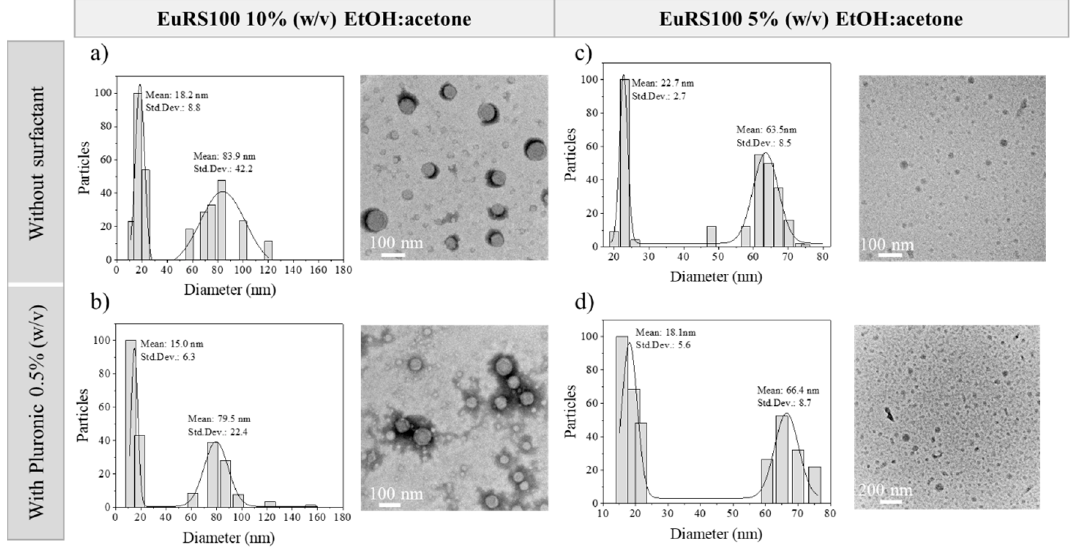
Figure 4. DLS size distribution, representative TEM ( a and b ) or SEM ( c and d ) images of the resulting nanoparticles. ( a ) Eudragit ® RS100 10% (w/v) EtOH:acetone, R = 5, without surfactant, ( b ) Eudragit ® RS100 10% (w/v) EtOH:acetone, R = 5, Pluronic 0.5% (w/v), ( c ) Eudragit ® RS100 5% (w/v) EtOH:acetone, R = 5, without surfactant, and ( d ) Eudragit ® RS100 5% (w/v) EtOH:acetone, R = 5, Pluronic 0.5% (w/v).